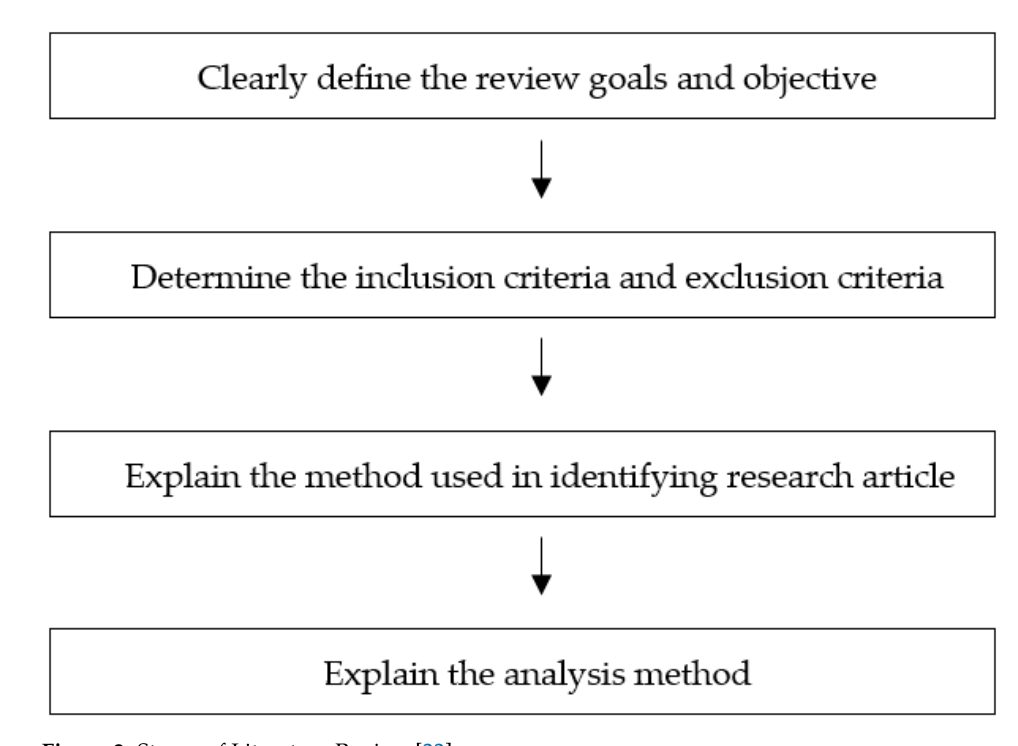
Figure 2. Stages of Literature Review